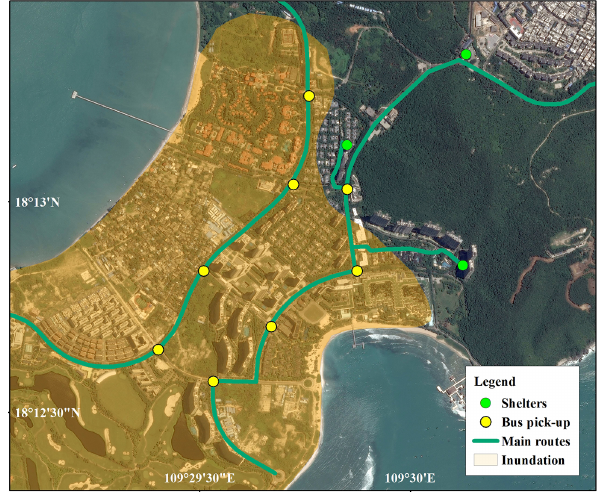
Figure 10. Pickup locations and main horizontal evacuation routes for the Luhuitou Community.